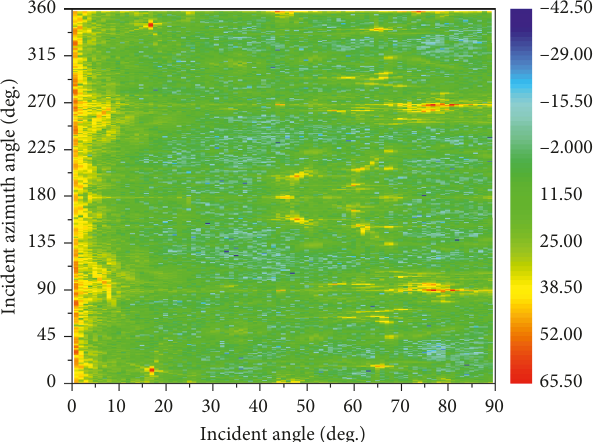
Figure 13: The change of RCS of the ship with scattering angle and scattering azimuth angle.